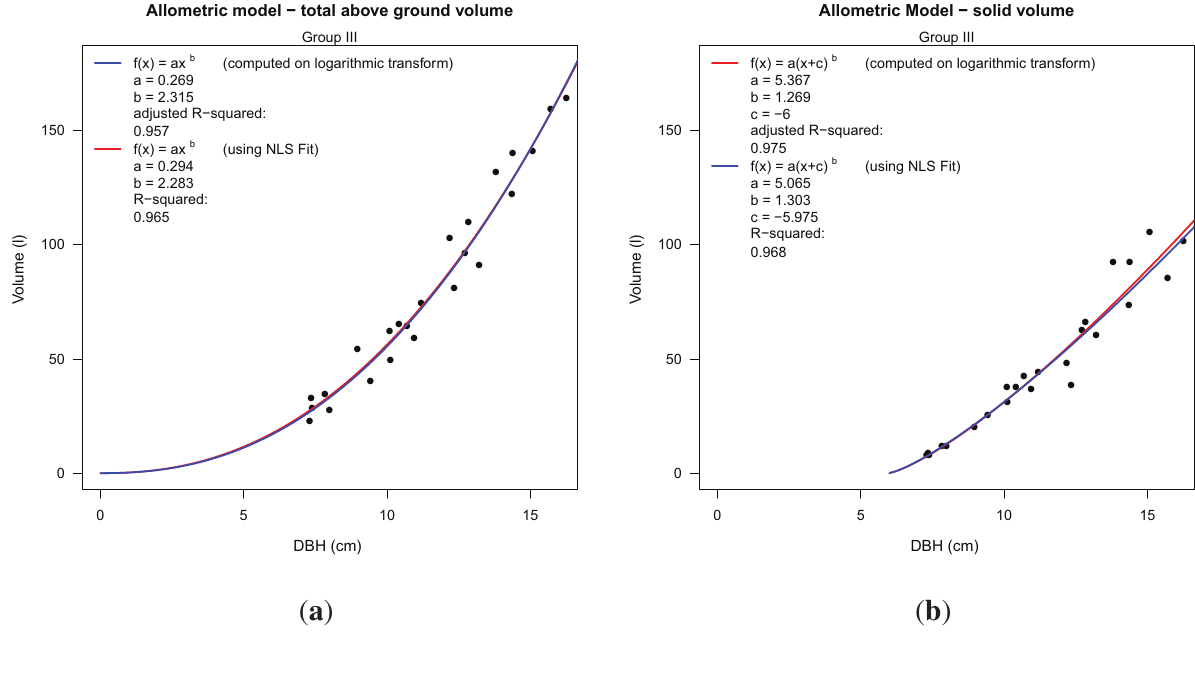
Figure 12. Two allometric models for volume estimation derived from 24 Group III models using TLS-derived DBH as the input variable: (a) total above-ground volume modeled as a function of DBH; (b) solid volume modeled as a function of